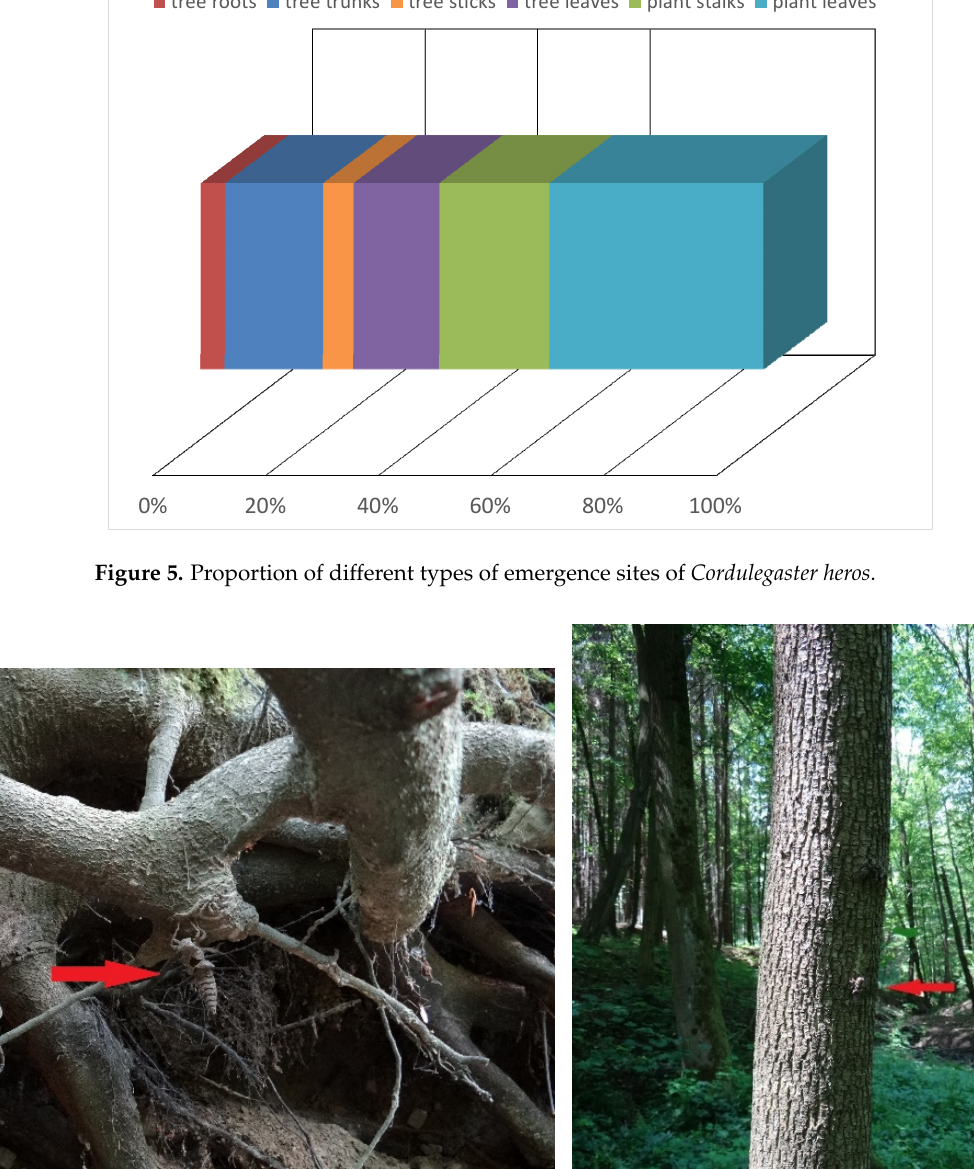
Figure 7. Position of exuviae of Cordulegaster heros in riparian parts of the habitat (x ‐ axes: ( − ) left bank, (+) right bank).